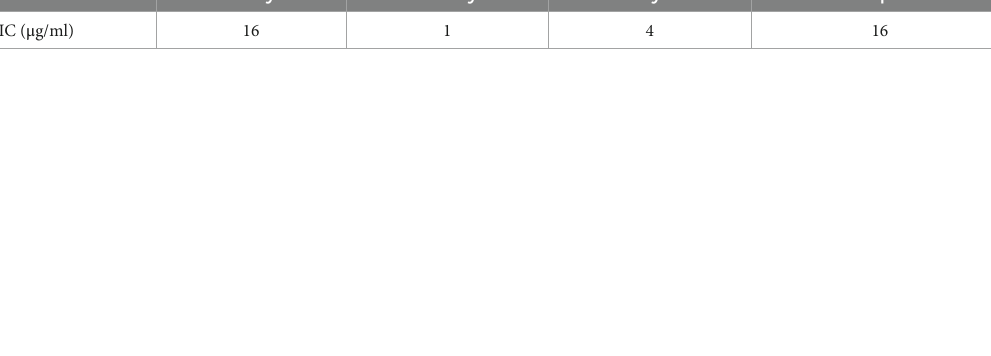
TABLE 2 The minimum inhibitory concentrations (MICs) of the tested antibiotics against Pseudomonas aeruginosa PAO1.